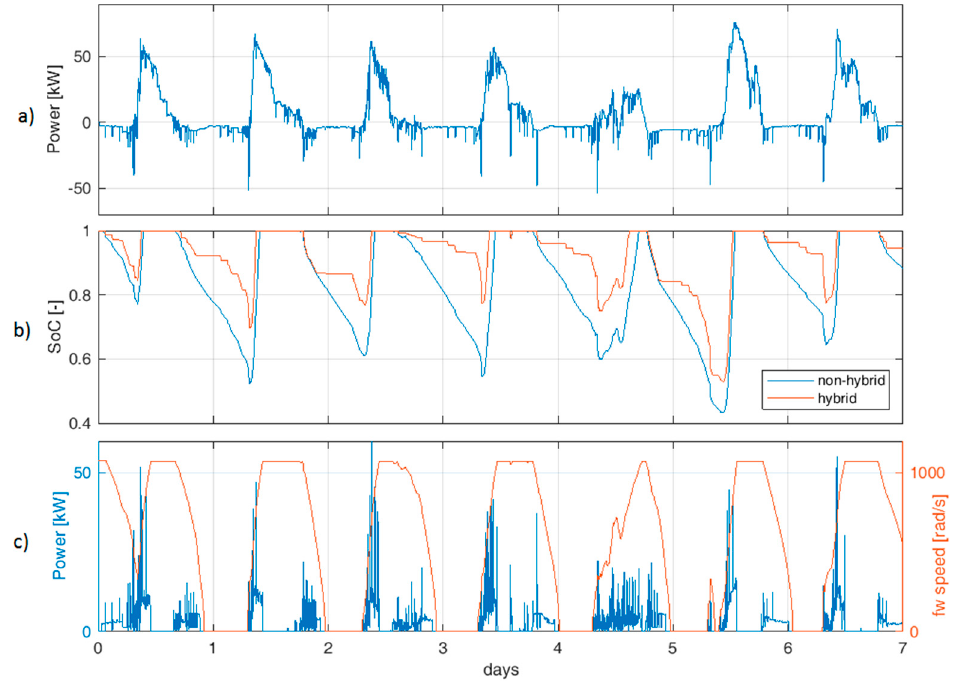
Figure 3. Main assessed parameters for configurations 1 (hybrid) and 2, respectively: a ) power di ff erence between PV production and L Kit load profile, b ) battery SoC in hybrid and non-hybrid cases, c ) flywheel power (absolute value) and speed (hybrid case).